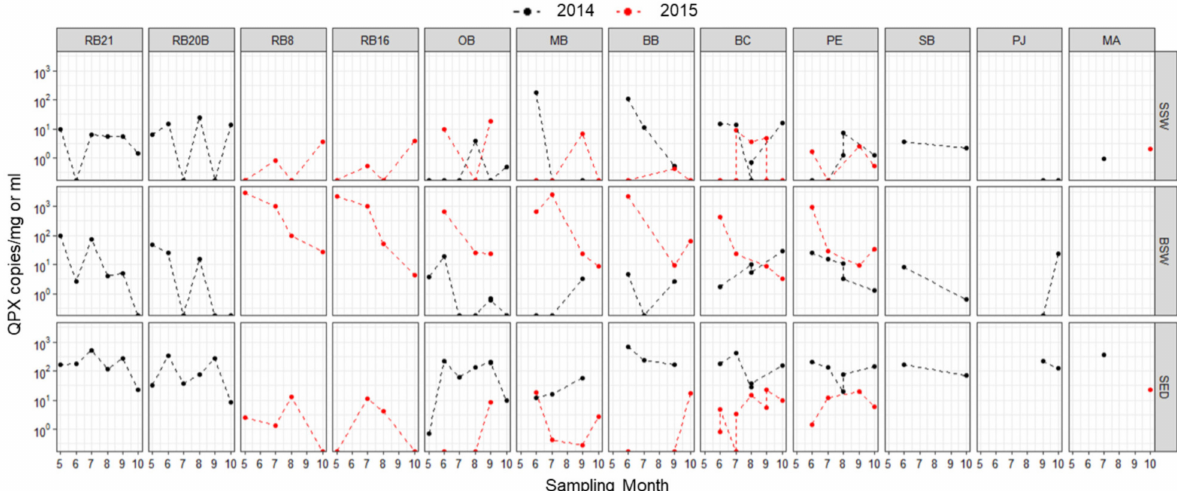
Figure 6. M. quahogii (QPX) abundance in environmental samples: surface seawater (SSW), bottom seawater (BSW), and sediment (SED), assayed using nqPCR. Values are expressed in terms of QPX gene copies per mL seawater or mg sediment on a log10